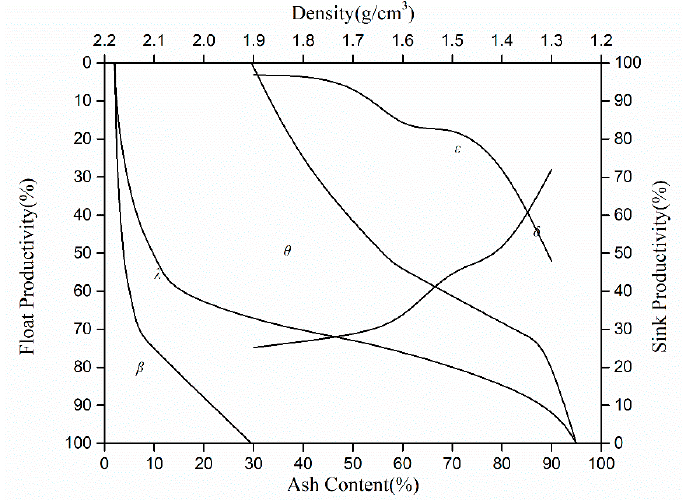
Figure 3. Washability curves of the feeding coal particles with size between − 6 and + 3 mm .